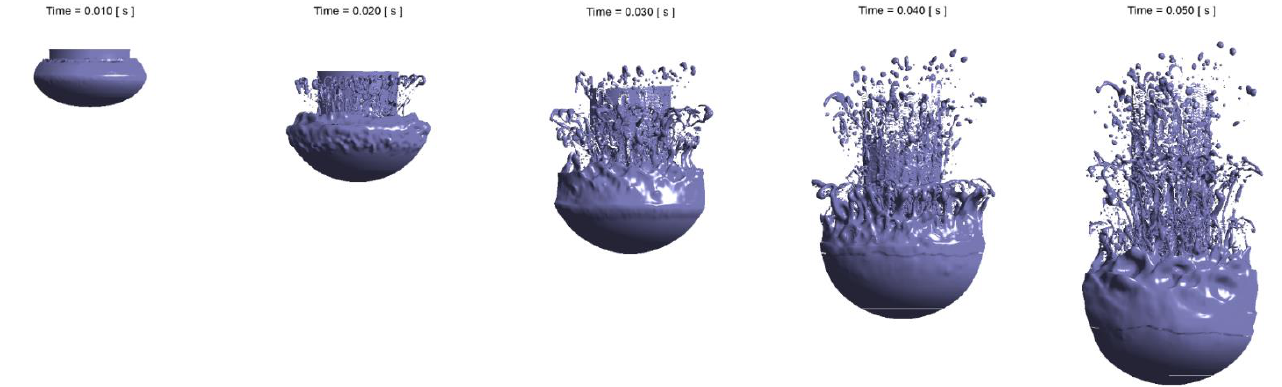
Figure 13. Iso-surface plot of melt volume fraction of 0.5 (V jet = 4.0 m/s).